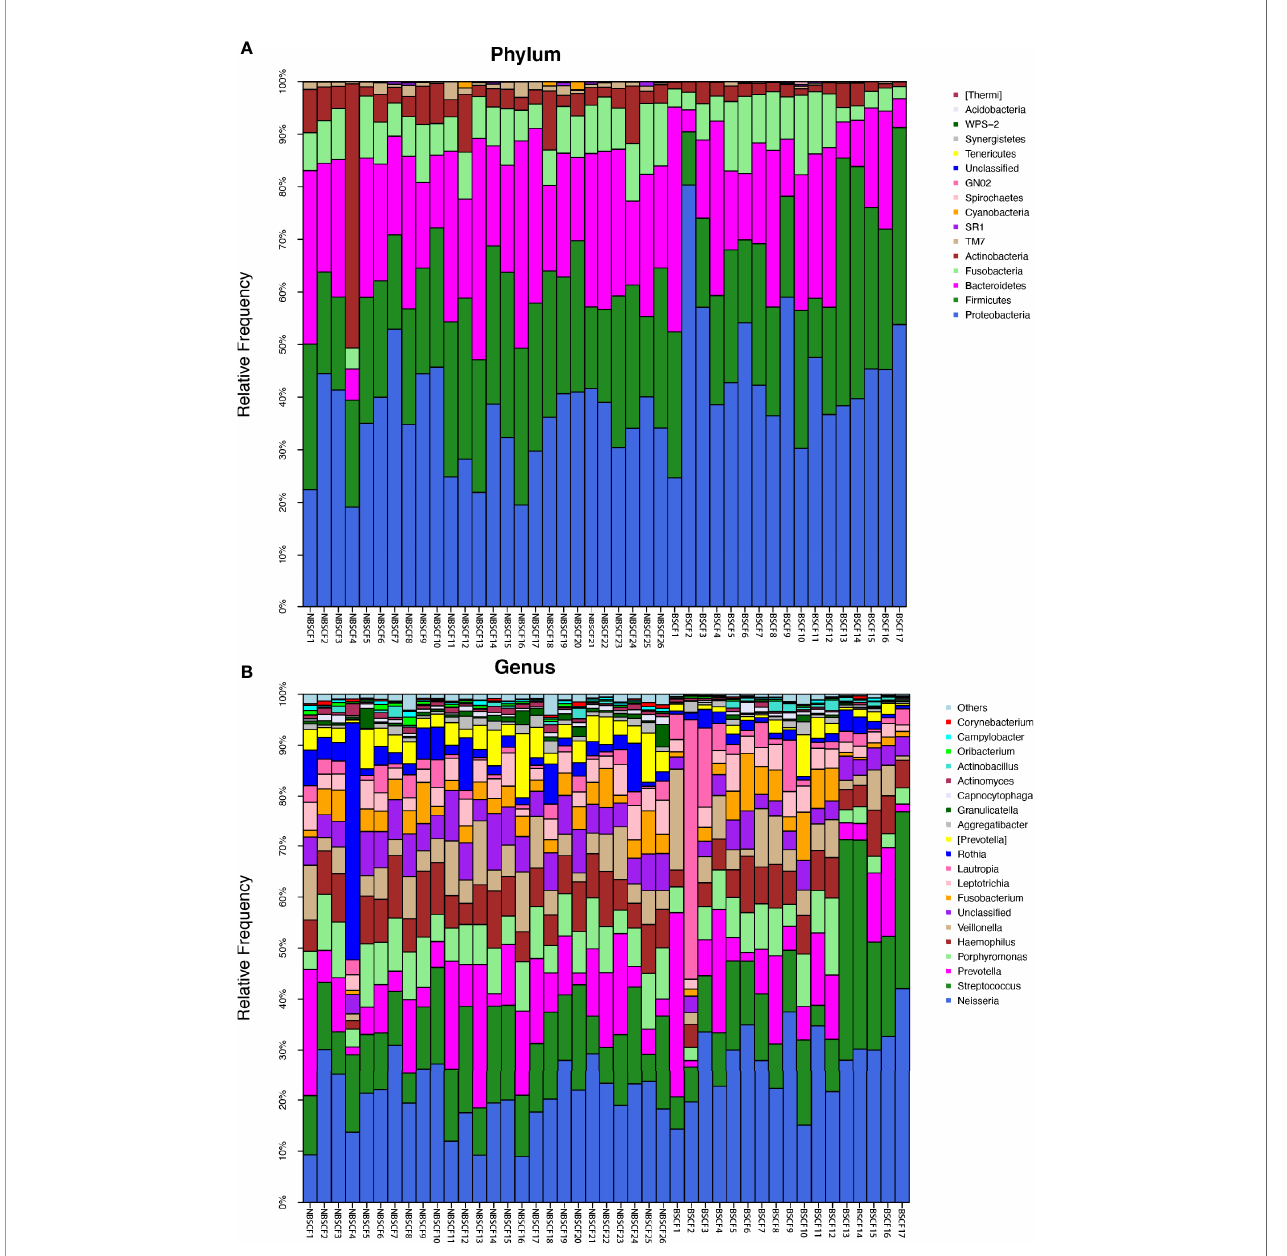
FIGURE 5 | (A) The composition of phyla with NBSCF and BSCF. Bar plot of percentage abundance at the phylum level in every sample. The horizontal axis is the name of each sample. They are NBSCF1-26 and BSCF1-17. (B) The composition of genera with NBSCF and BSCF. Bar plot of percentage abundance at the genus level in every sample. The horizontal axis is the name of each sample. They are NBSCF1-26 and